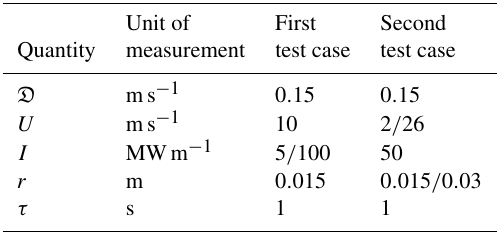
Table 2. Values of the main parameters for numerical simulations performed with LSFire+